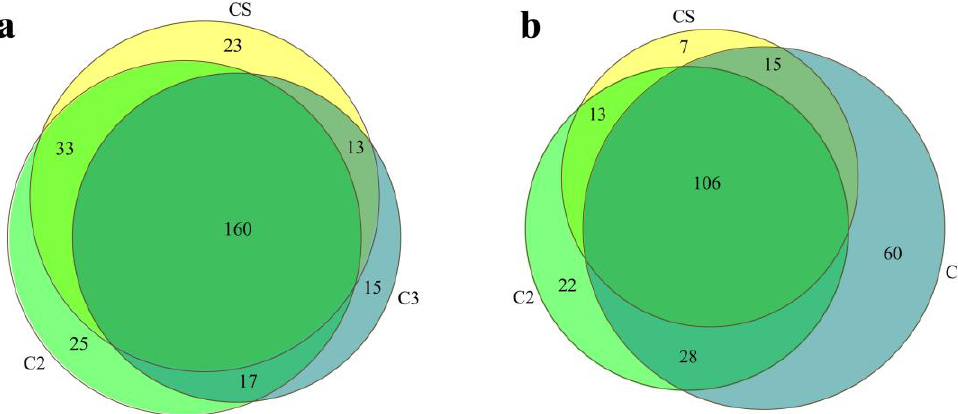
Figure 3. Analysis of the common and unique microorganisms from fermented grains at the genus level. ( a ) bacteria. ( b ) fungi. CS, round 1b. C2, round 2. C3, round 3. level. ( a ) bacteria. ( b ) fungi. CS, round 1b. C2, round 2. C3, round